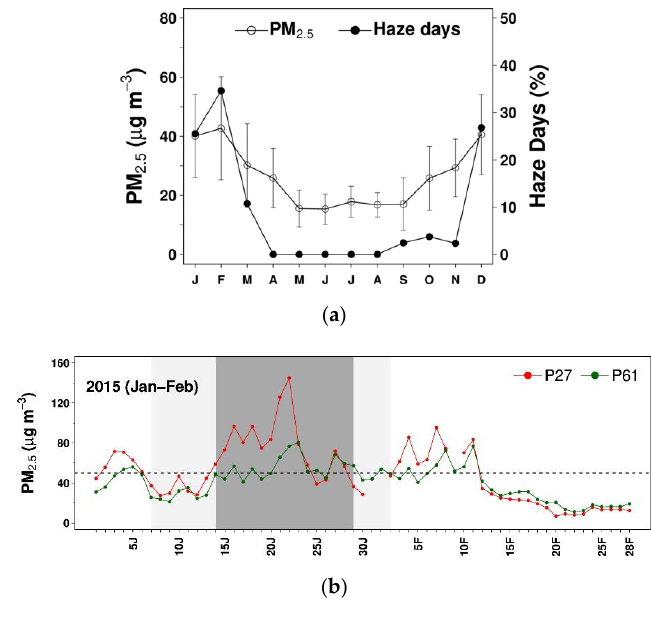
Table 1. Monitoring stations considered in this